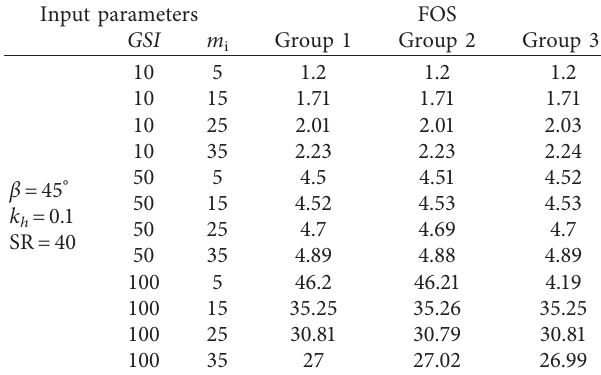
Table 2: Comparison of the FOS for a given rock slope with various HB